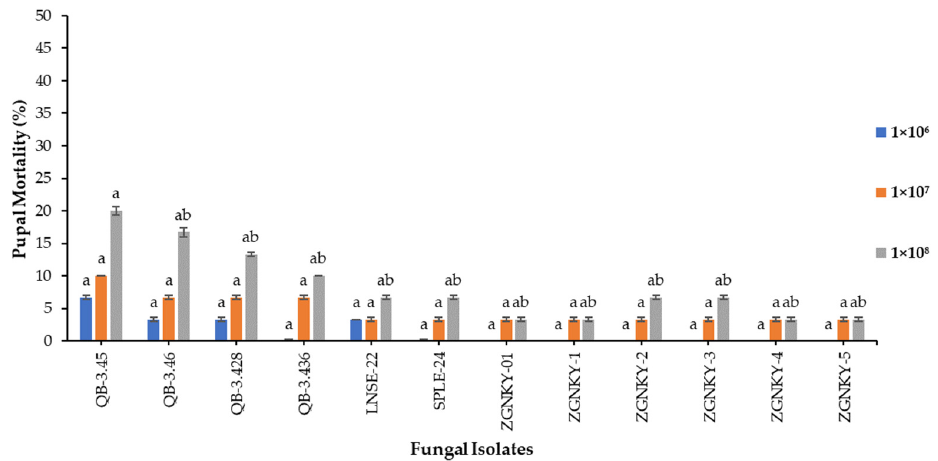
Figure 5. The mortality of pupae infected with different concentrations of B. bassiana isolates. Means followed by the same letters are not significantly different according to Tukey’s test at p < 0.05. Factorial analysis of variance revealed a significant effect of the conidial concentra- tions (F 2, 286 = 280.34; p > 0.000), the treatments (F 11, 286 = 106.20; p > 0.000), the life stages (F 3 , 286 = 432.47; p > 0.000), and the interaction (F 66, 286 = 1.66; p > 0.002) on the mortality of FAW